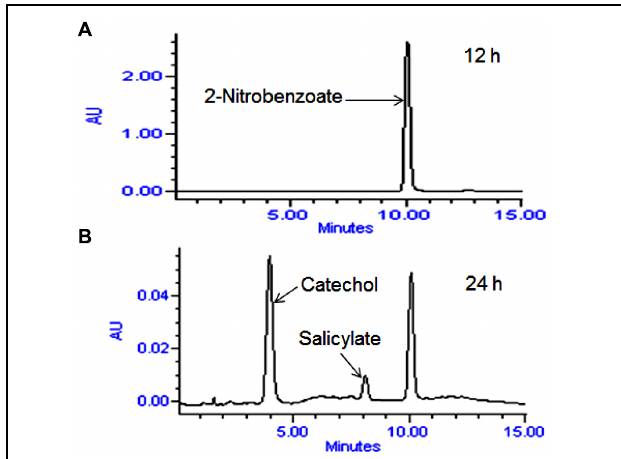
FIGURE 2 | High performance liquid chromatography (HPLC) elution profiles of the samples during the 2NB degradation. (A) 12 h sample showing only the peak of 2NB; and (B) 24 h sample showing the peaks of two metabolites along with the 2NB.